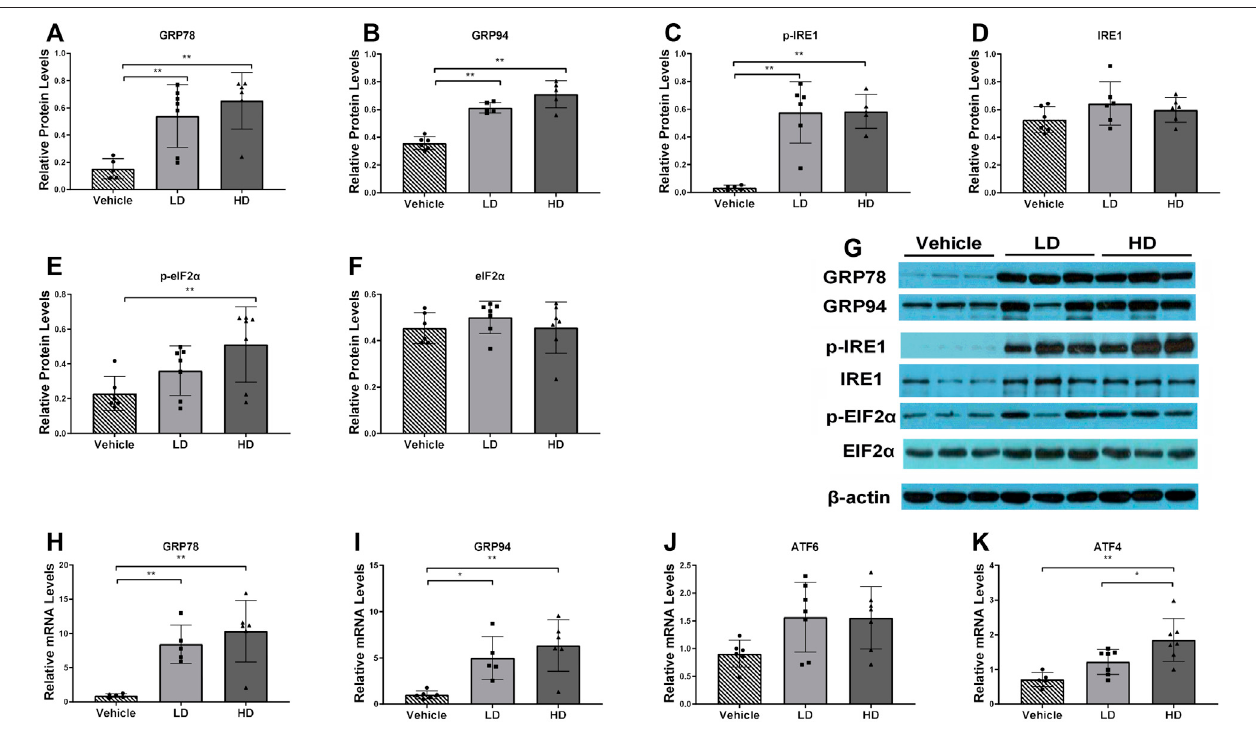
FIGURE 1 | ERS model was successfully established in piglets using different doses of tunicamycin. Piglets were administered with low dosage (LD) tunicamycin (TM) (0.1 mg/kg body weight), high dosage (HD) TM (0.3 mg/kg body weight), or vehicle (5% DMSO) for 48 h. (A – F) Relative protein levels of GRP94, GRP78, p-IRE1, IRE1, p-EIF2 α , EIF2 α , and β -actin were assessed using Western blot analysis in different TM treatment groups. (H – K) Relative mRNA levels of GRP94, GRP78, ATF6, and ATF4 were measured by real-time RT-PCR. * means p < 0.05; ** means p < 0.01.